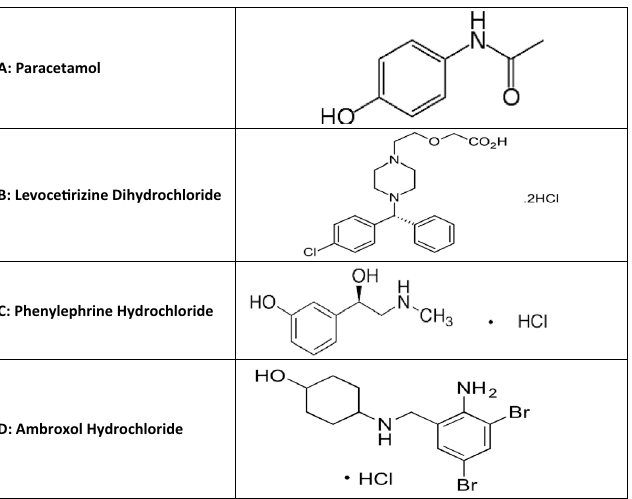
Figure 1. Chemical structure of ( A ) paracetamol, ( B ) levocetirizine dihydrochloride, ( C ) phenylephrine hydrochloride, ( D ) ambroxol